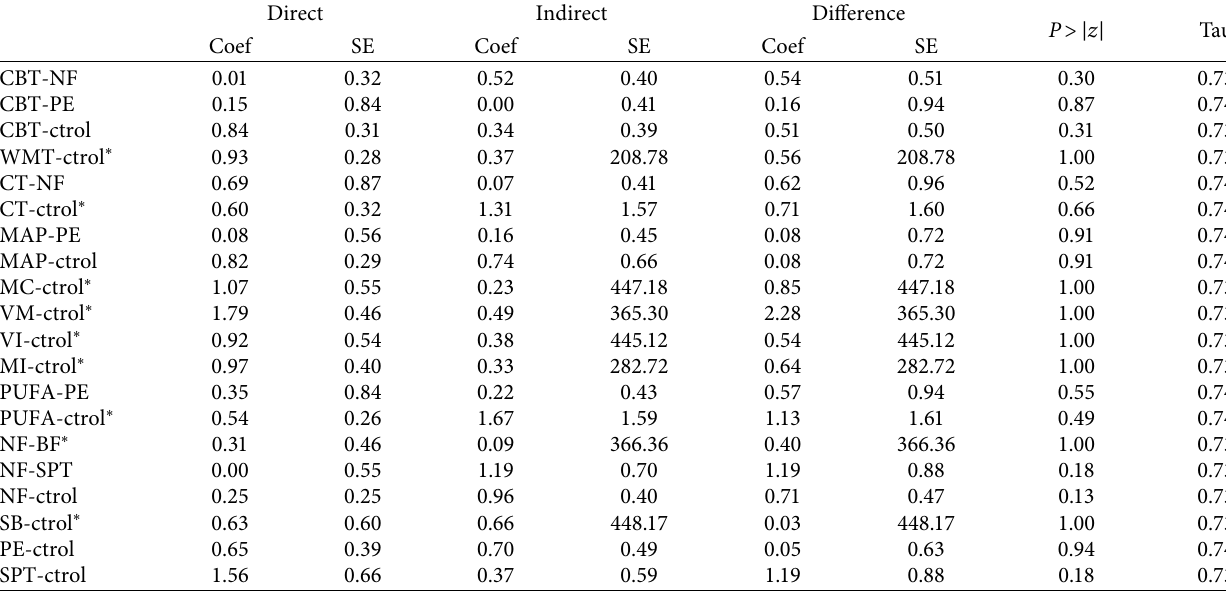
Table 3: Local inconsistency